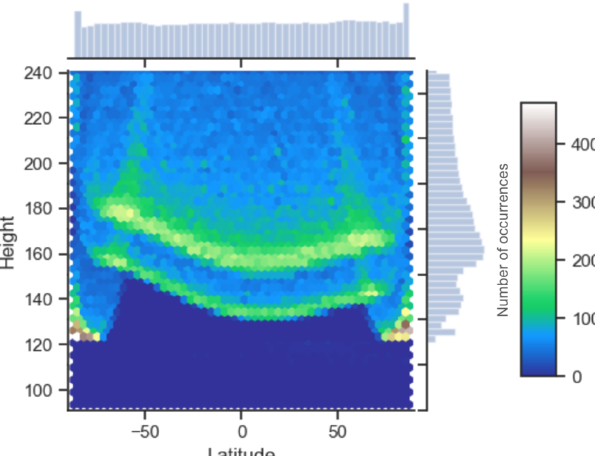
Figure 15. Sample altitude coverage (below 250km) at various lat- itudes. Colors indicate the total number of occurrences that fall within each latitude–altitude bin.